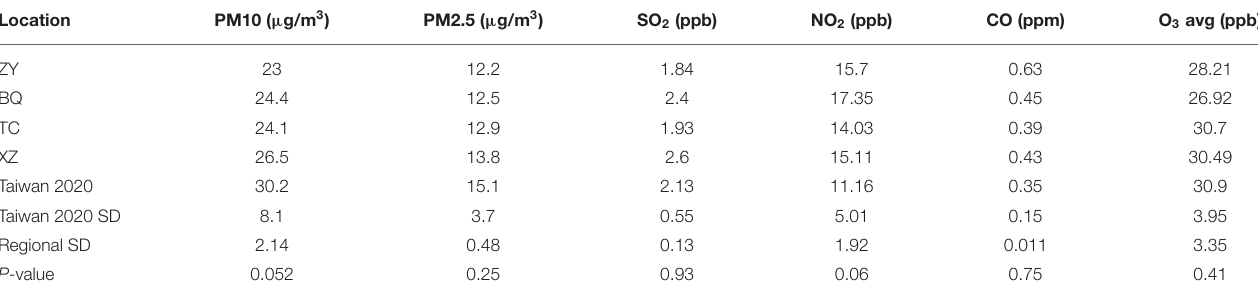
TABLE 5 | The concentration of ambient air pollutants in